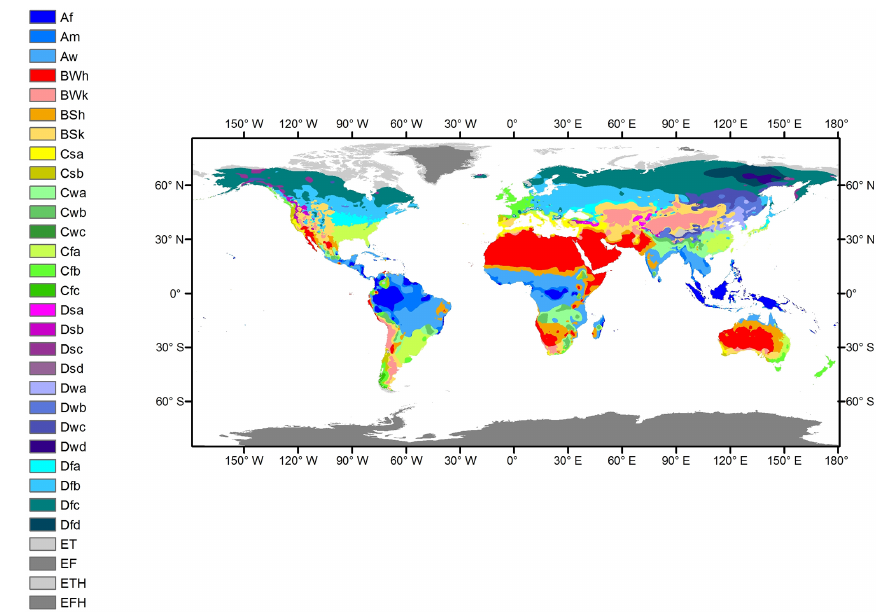
Figure 4. The Köppen–Geiger climate classification global map at a resolution of 5arcmin (Peel et al., 2007). Table 4. Linear multiple regression equations for different climate zones, relating high resolution R factor from the USA with one or more significant parameters: annual total mean precipitation, P (mm), mean elevation, z (m), and the simple precipitation intensity index, SDII (mmday − 1